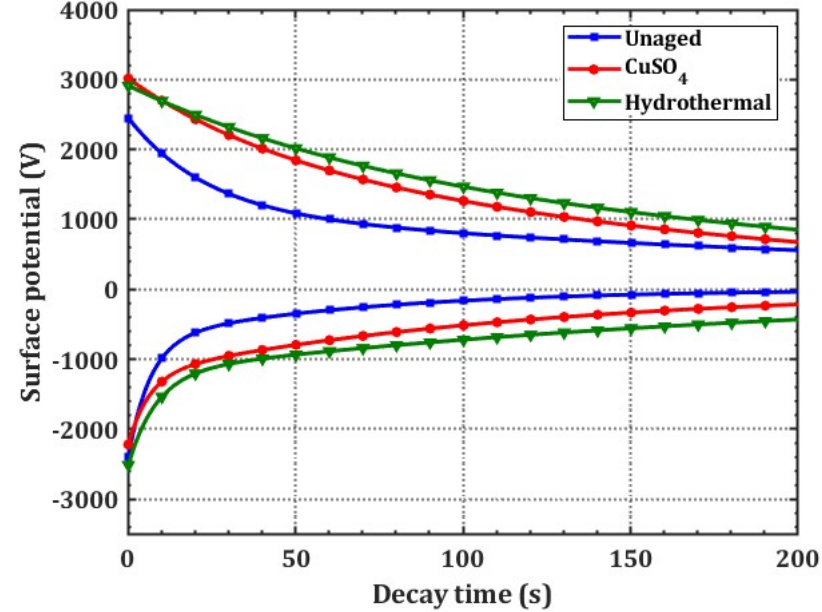
Figure 6. Variation in surface potential decay curves for both polarities.